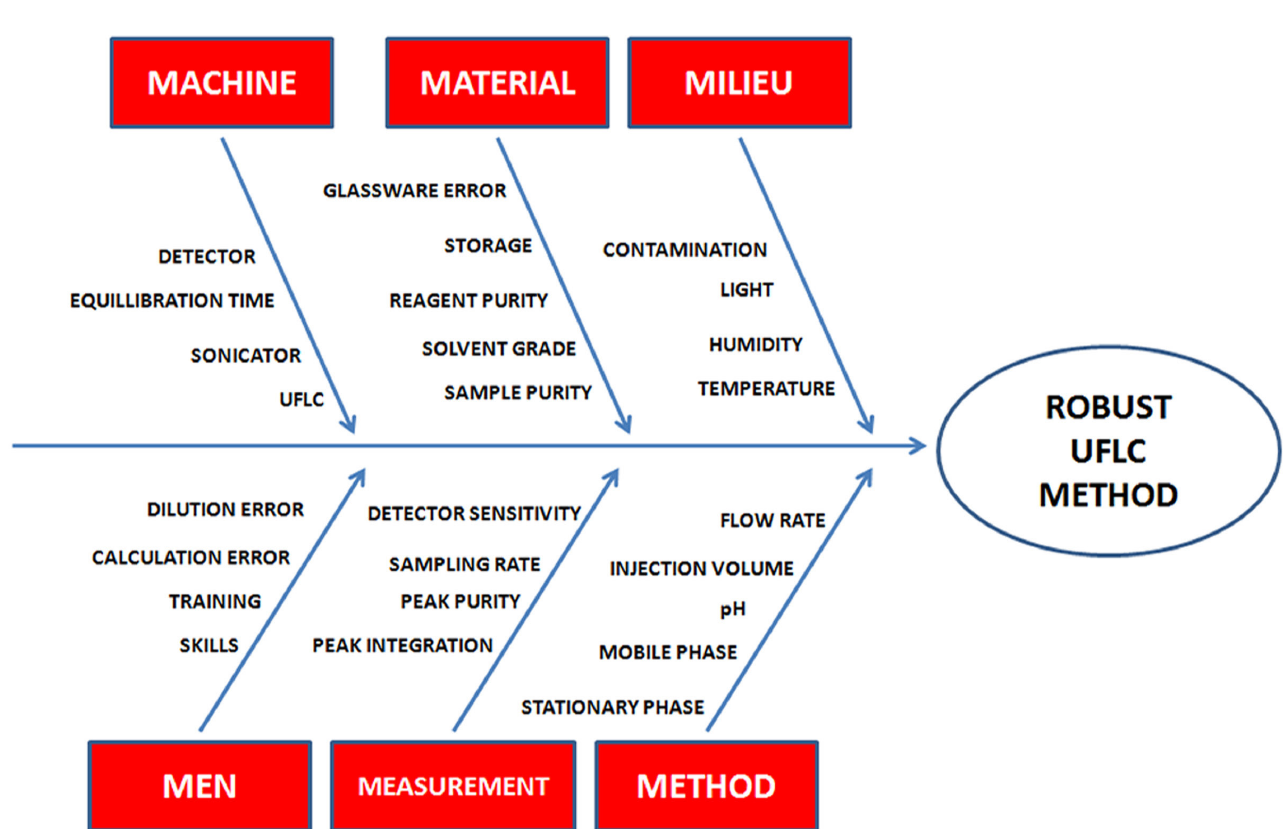
FIGURE 2 - Fish-bone diagram explaining causal-effect relationship between variables and method